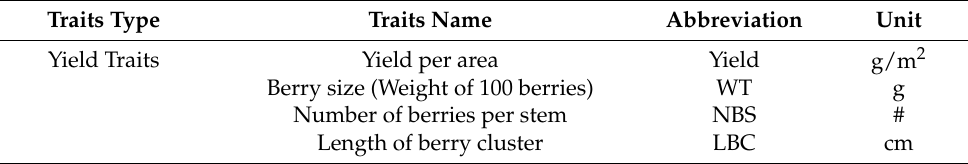
Table 1. List of yield-related, morphological, and functional traits used in this study along with their abbreviations and